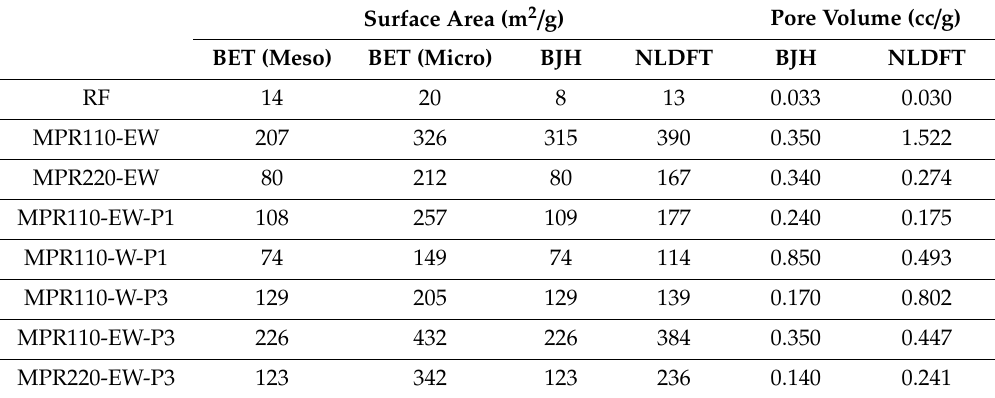
Table 1. Surface Area and volume distribution of various catalysts based on BJH and NLDFT models (RF = non-porous resorcinol-formaldehyde resin, 110 and 220 = 110 mg and 220 mg PEI respectively; EW = ethanol-water, W = water solvent P1 and P3 = 1 wt % Pd and 3 wt % Pd,